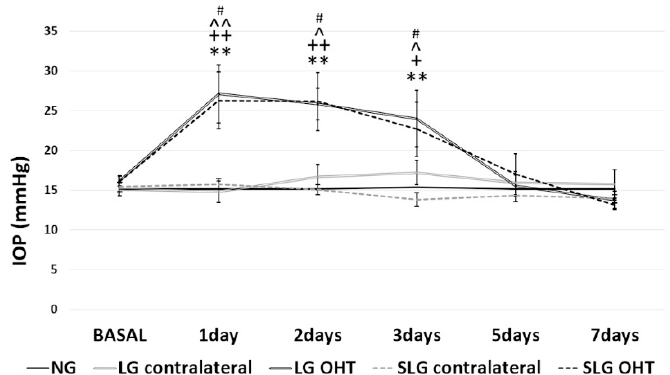
Figure 1. Intraocular pressure (IOP) in the different study groups after laser treatment. Data are shown as means ( ± standard deviation, SD). Abbreviations: Naïve age-matched control (NG), lasered group contralateral (LG contralateral), lasered group ocular hypertension (LG OHT), lasered group contralateral + saffron (SLG contralateral), lasered group ocular hypertension + saffron (SLG OHT). Statistical significance indicators: ** p < 0.01 for NG vs. LG OHT; + p < 0.05, ++ p < 0.01 for NG vs. SLG OHT; ^ p < 0.05, ^^ p < 0.01 LG contralateral vs. LG OHT; # p < 0.05 SLG contralateral vs. SLG OHT.